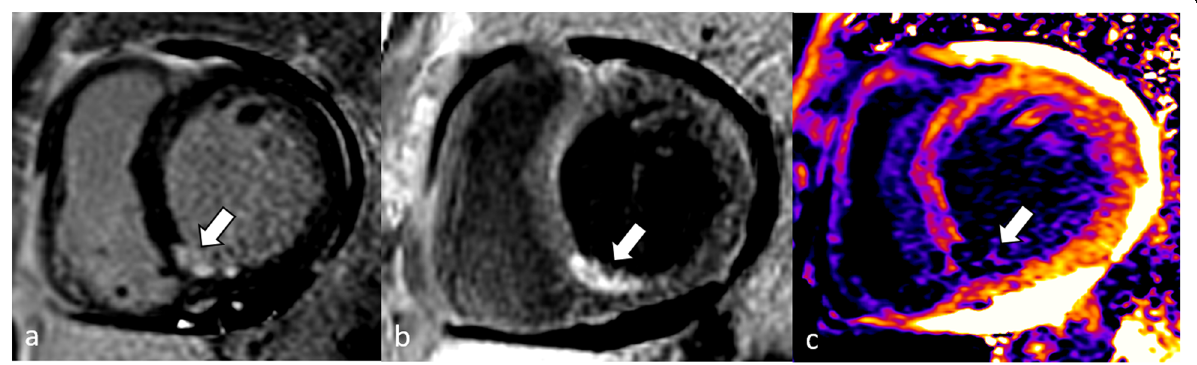
Fig. 4 Conventional LGE ( a ), dark blood LGE ( b ), according Muscogiuri et al [108], and T1 map ( c ) are shown in a 62-year-old male with known coronary artery disease. Conventional LGE shows small area of hyperenhancement in the inferoseptal and inferior segments (white arrow), corresponding to myocardial infarct in the right coronary artery territory. The same area is depicted by dark-blood LGE and the T1 map (white arrows). Note that the discrimination of blood and infarct signals is improved on dark-blood LGE compared with the conventional technique. LGE Late gadolinium